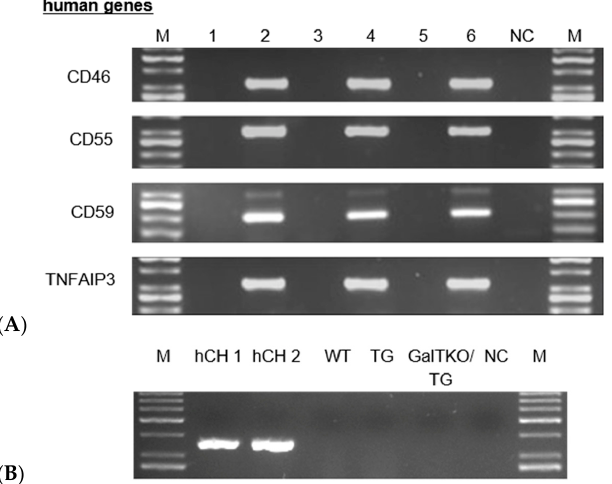
Figure 3. Expression of human transgenes in porcine chondrocytes. ( A ) Representative RT-PCR of WT and genetically modified porcine chondrocytes regarding human CD46, CD55, CD59, TNFAIP3; porcine GAPDH served as control (shown in Figure 1). The corresponding samples were loaded for electrophoresis in the following order: lane M: bp marker; lane 1: WT; lane 2: TG; lane 3: GalTKO; lane 4: GalTKO/TG; lane 5: GalT/CMAHKO; lane 6: GalT/CMAHKO/TG; NC: negative control ( B ) HMOX1 gene expression in human (hCH) and porcine chondrocytes (WT, TG and GalTKO/TG).